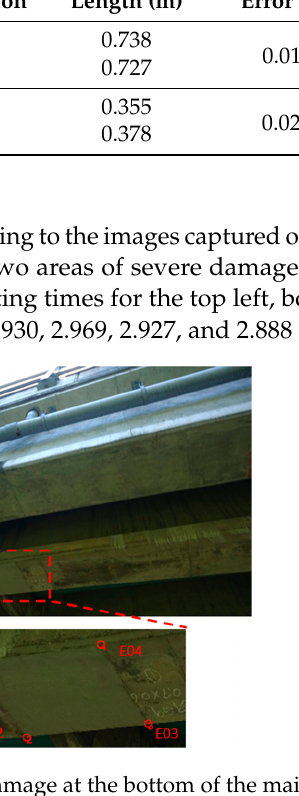
Table 6. Accuracy analysis for side length measurement at a photo-shooting distance of approximately 4.6 m.